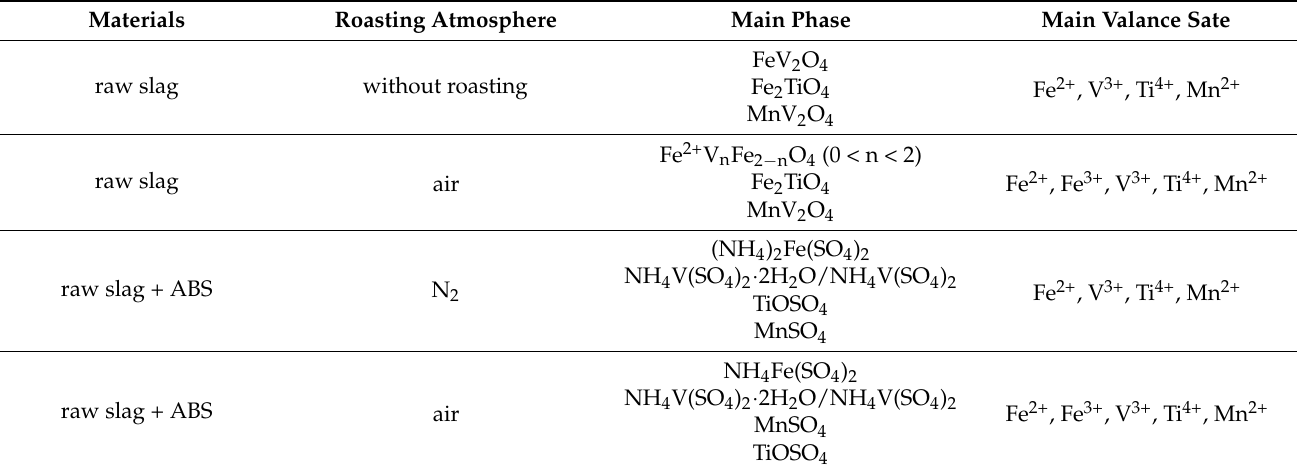
Table 4. Phase transformation of Fe, V, Ti and Mn compounds in vanadium slag via roasting. Materials Main Phase Main Valance